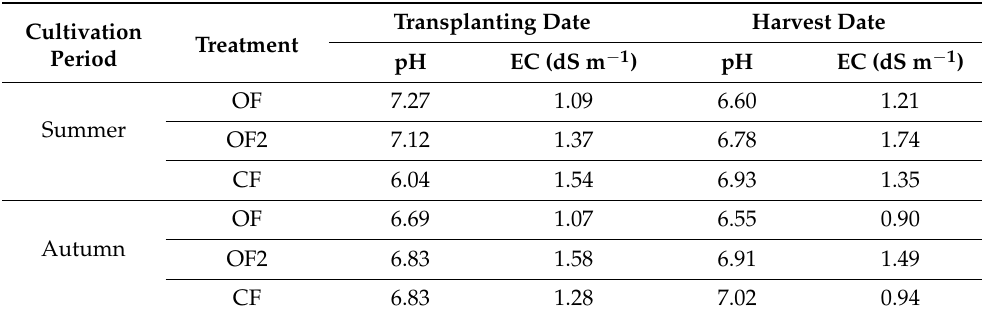
Table 1. Electric conductivity (EC) and pH of hydroponic